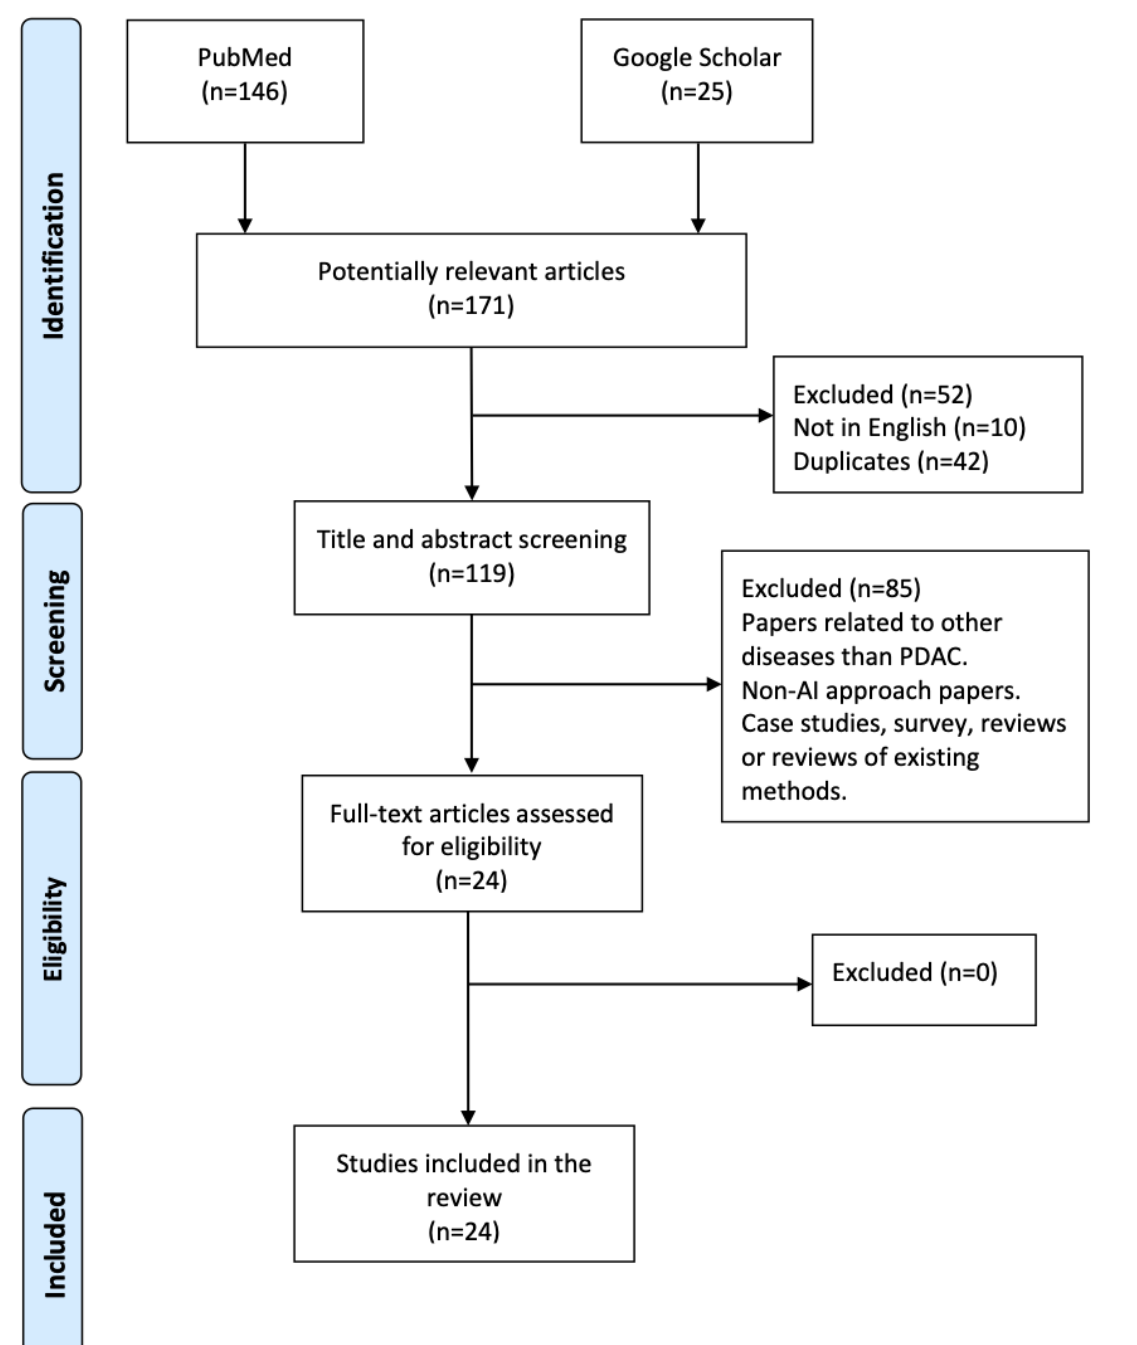
Figure 3. PRISMA flow chart showing the selection criteria of the publications to include in this review. AI: artificial intelligence; PDAC: pancreatic ductal